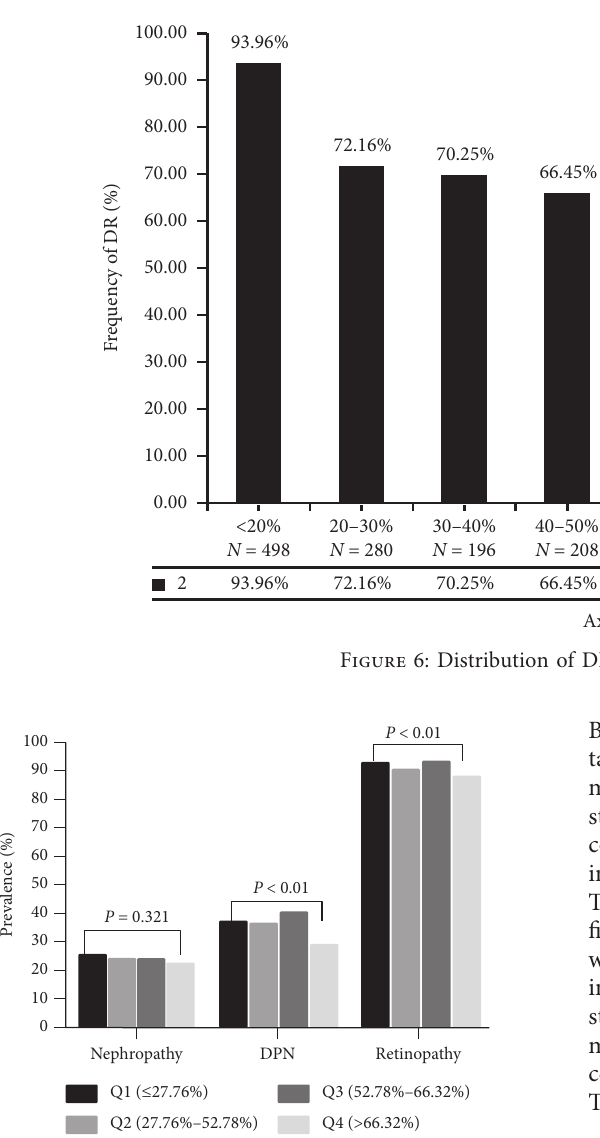
Figure 7: Relationship between TIR quartile and